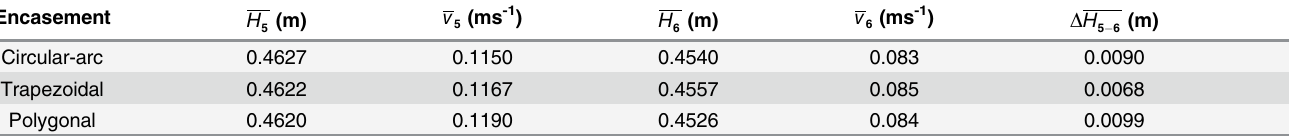
Table 5. Estimated parameters at CS5 to CS6 for an annual discharge.